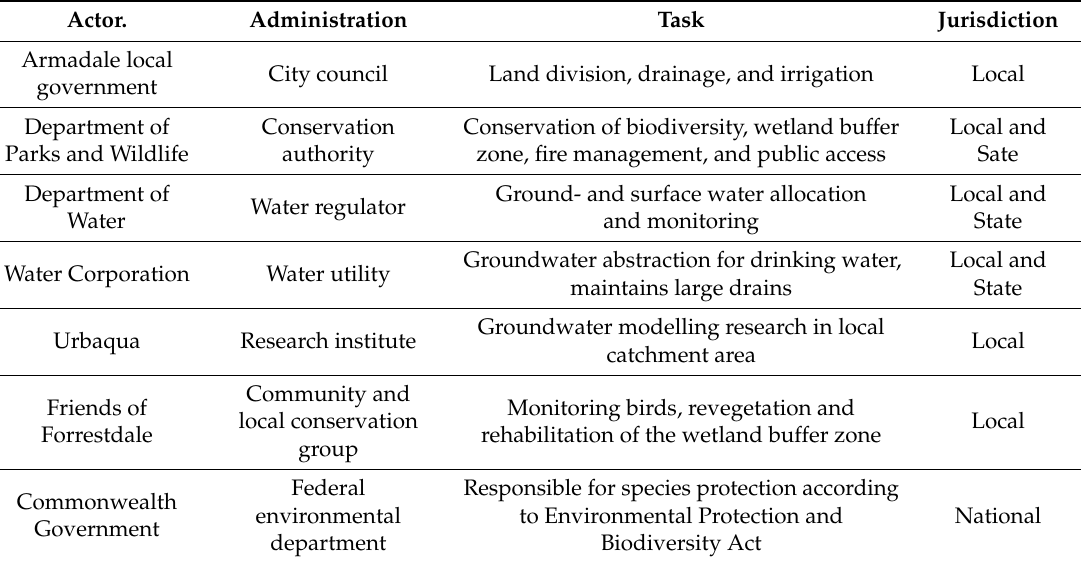
Table 1. Overview of the actors (stakeholders) involved in the conservation of the wetland.